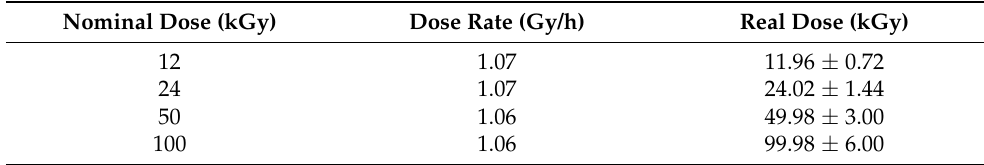
Table 1. Irradiation